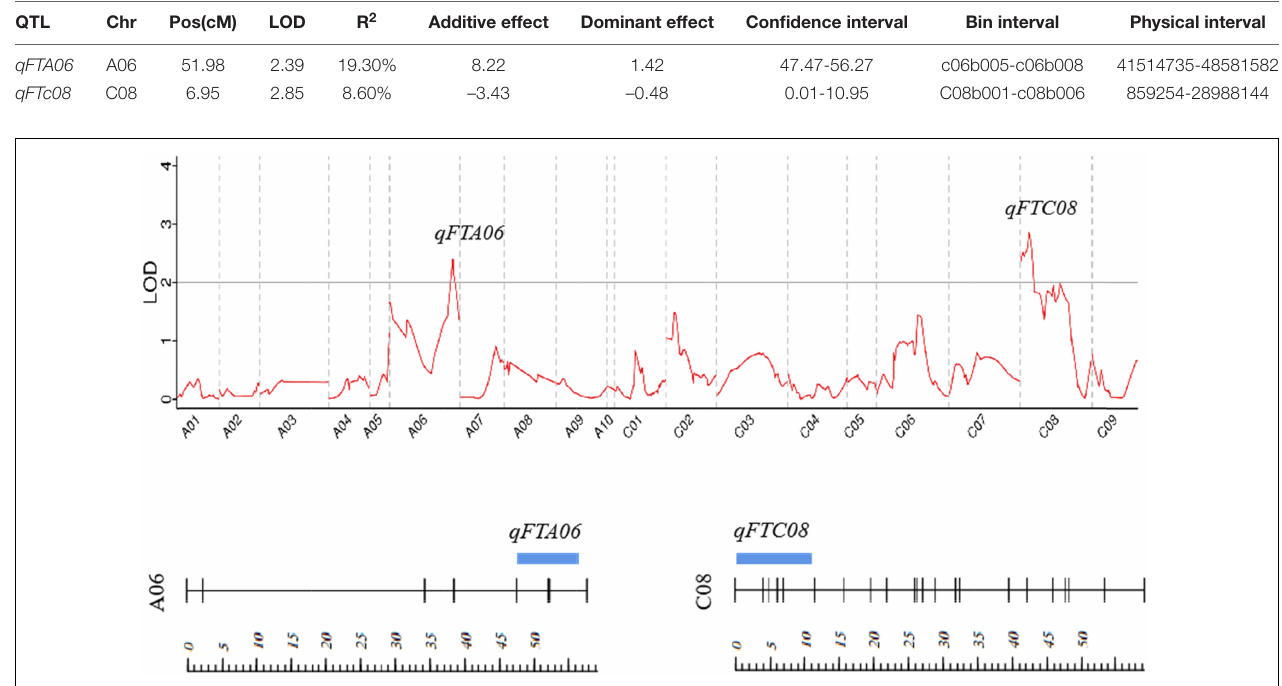
TABLE 3 | Detailed information of QTL for flowering time.